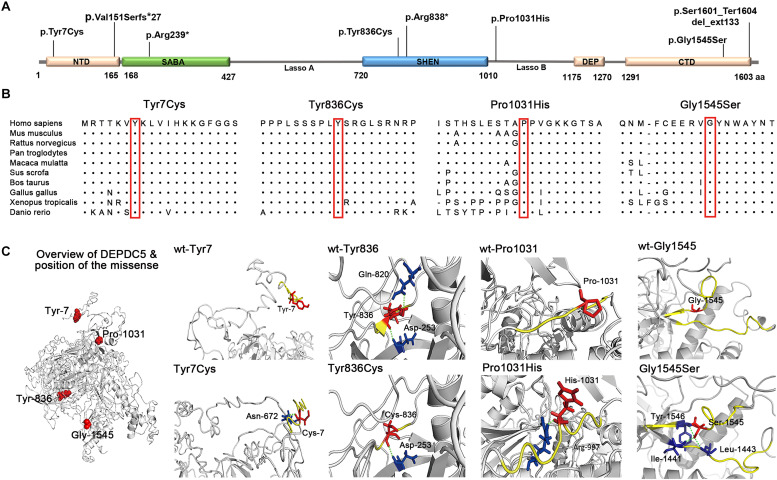
Schematic presentation of DEPDC5 structure. (A) The positions of the mutations identified in this study are indicated relative to functional domains. (B) All four missense mutations identified in this study affected amino acid residues that are highly conserved in various species. (C) Overview of DEPDC5 and focal structures of wild type and mutants. The residues where the mutations occurred are shown as red rods. The hydrogen-bonded residues are colored blue. The hydrogen bonds are shown as green spheres. The yellow-colored structure where Tyr836 located is a short β sheet. NTD, N-terminal domain; SABA, structural axis for binding arrangement; SHEN, steric hindrance for enhancement of nucleotidase activity; DEP, disheveled, Egl-10 and pleckstrin; CTD, C-terminal domain.